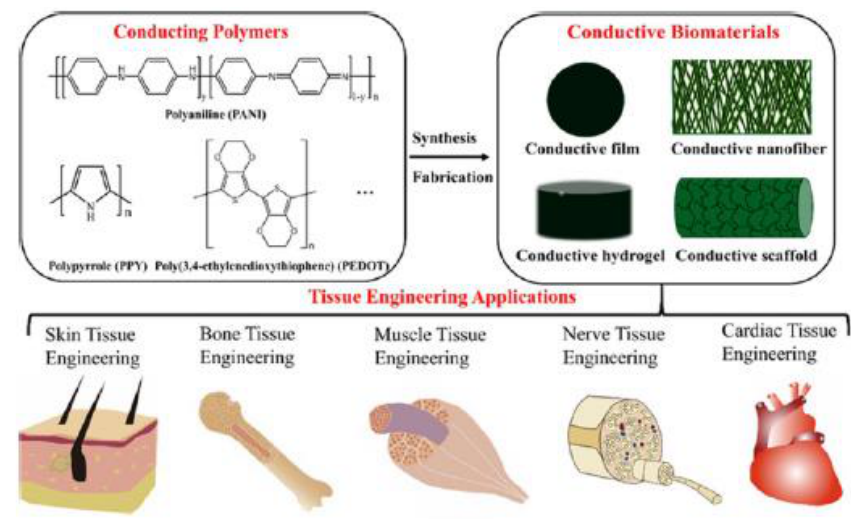
Figure 7. Schematic illustration of the constituent factors used in TE [249]. Reprinted with permission from Reference [249]. Copyright 2019 American Chemical Society.